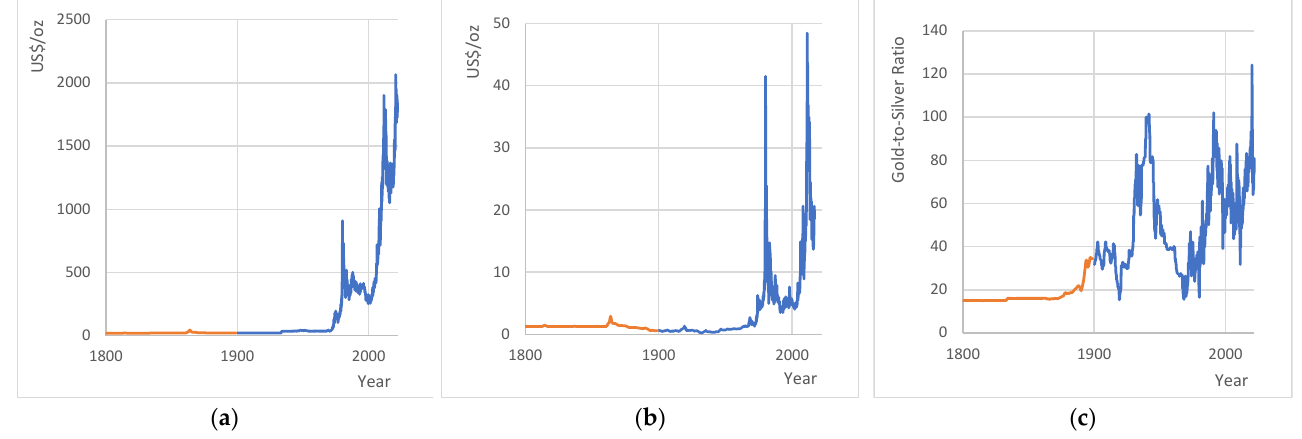
Figure 5. ( a ) Values of gold [29]. ( b ) Values of silver [30]. ( c ) Gold-to-Silver ratio. The last attempt to consolidate the relation of money to precious metals was made in widely known as the Bretton Woods Agreement [31].